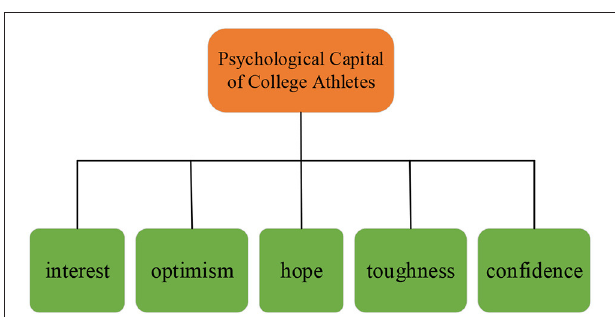
FIGURE 2 | Measurement dimensions of psychological capital of college